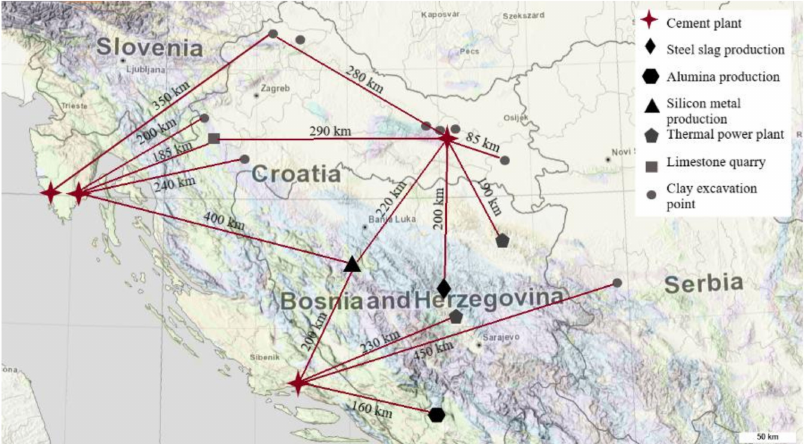
Figure 1. Map of the region [16] with indicated locations of industrial waste materials or excavations sites and their distances from four cement producers in